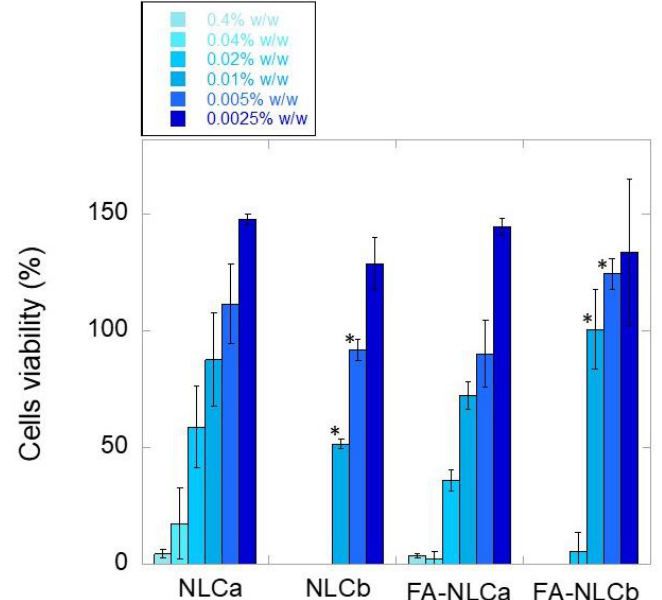
Figure 5. Murine fibroblasts viability after contact for 24 h with unloaded and FA-loaded NLC at different concentrations. Results are reported as the mean value ± SD of three separate experiments, each performed in triplicate. * Significance for p < 0.05, comparison between FA-loaded NLC and the respective unloaded NLC.